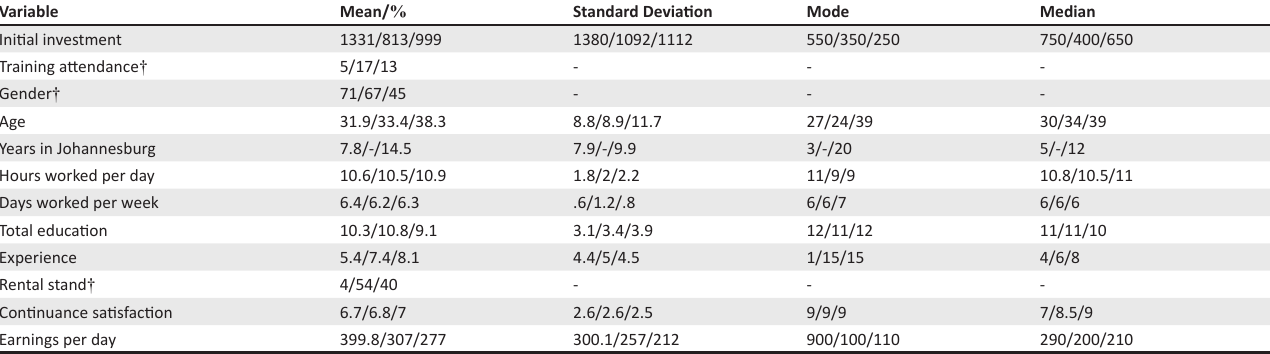
TABLE 1: Means, standard deviations, modes and medians (2010): Foreign Origin/Johannesburg origin/South African but not Johannesburg origin.